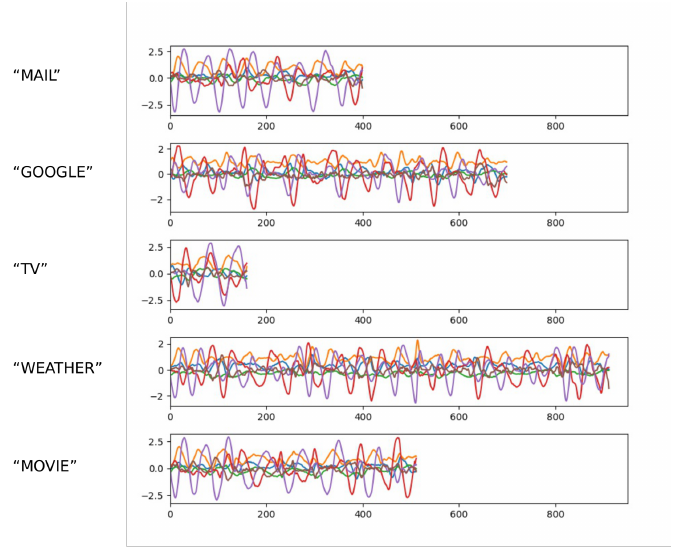
Figure 7. Samples in the air-writing word dataset (word-6DMG)